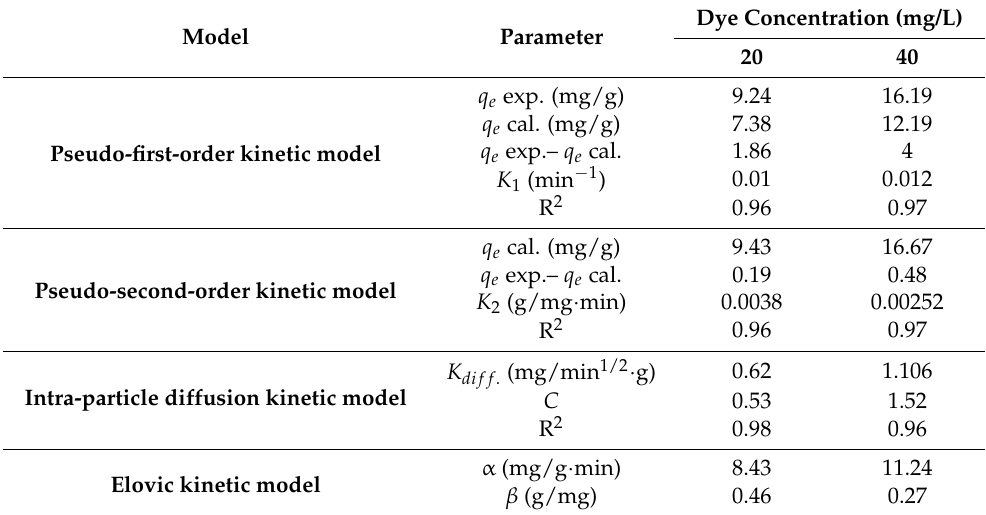
Table 2. CR dye adsorption parameters on ZnS nanoparticles using various kinetic models (exp. = ex- perimental; cal. =